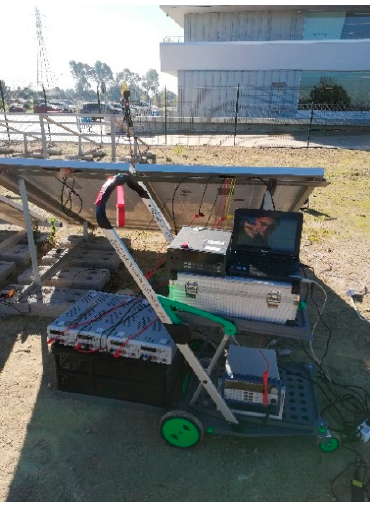
Figure 2. Disposition of the equipment used during the first and second tests.